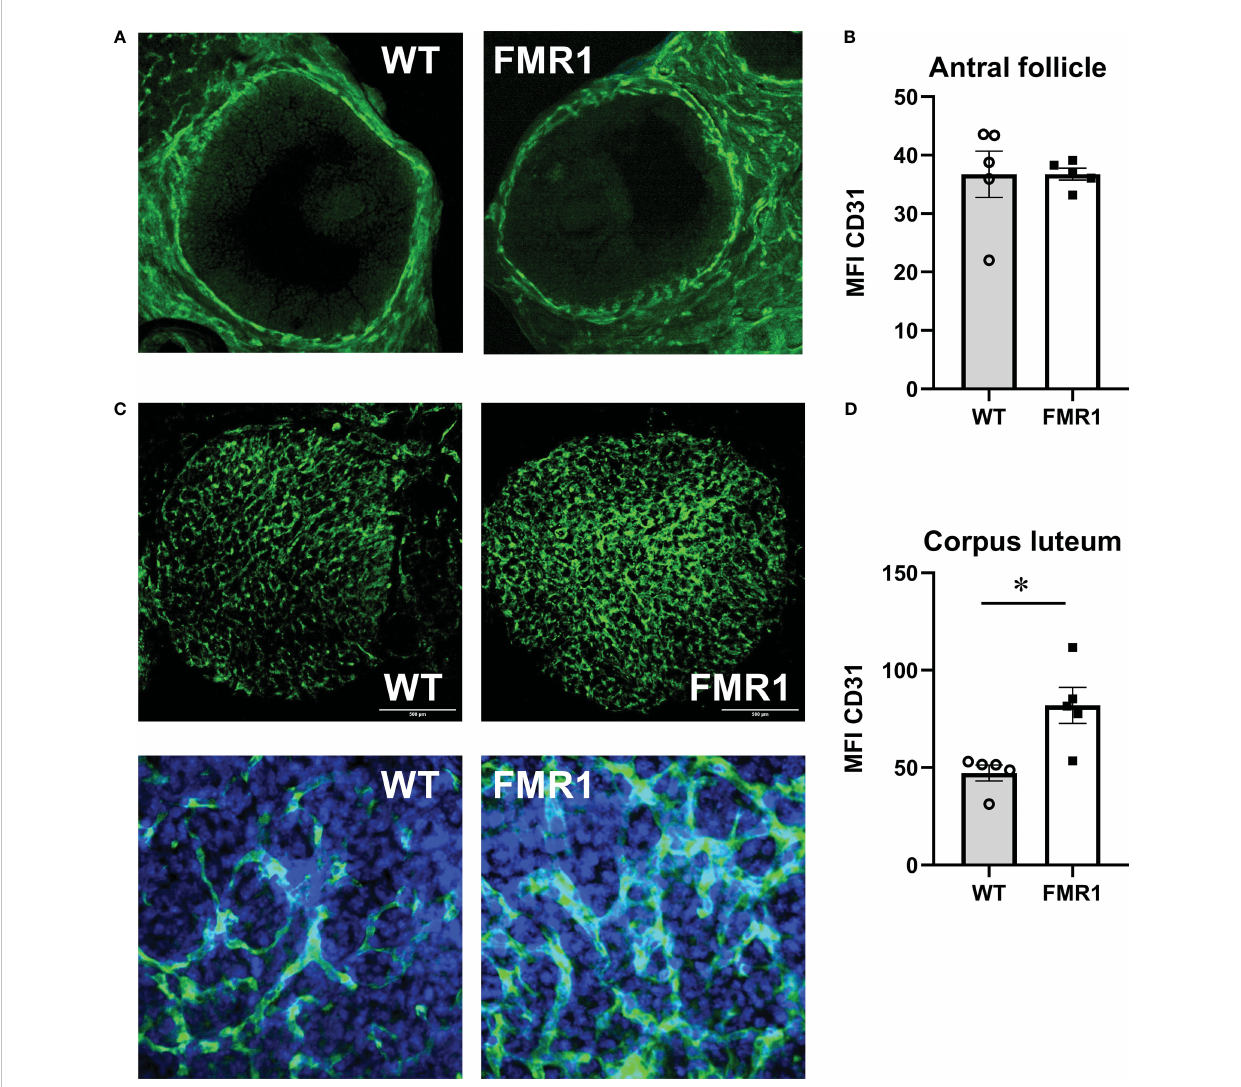
FIGURE 5 Fmr1 KO have increased corpus luteum vascularization. Ovaries were sectioned and stained with antibodies to CD31 (PECAM-1, Platelet endothelial cell adhesion molecule) to visualize vascularity. Mean fl uorescent intensity (MFI) was determined using Fiji imageJ. Consistent areas were used to quantify fl uorescence intensity. (A) Representative images of antral follicles. (B) MFI quanti fi cation. (C) Corpora lutea representative images; top, 1.6 mm x 1.6 mm area, CD31 green; bottom, 300 m m x 300 m m area, CD31, green, DAPI, blue. (D) MFI quanti fi cation. Statistical signi fi cance, indicated with a * (p < 0.05) was determined with t-test followed by Tukey ’ s post hoc